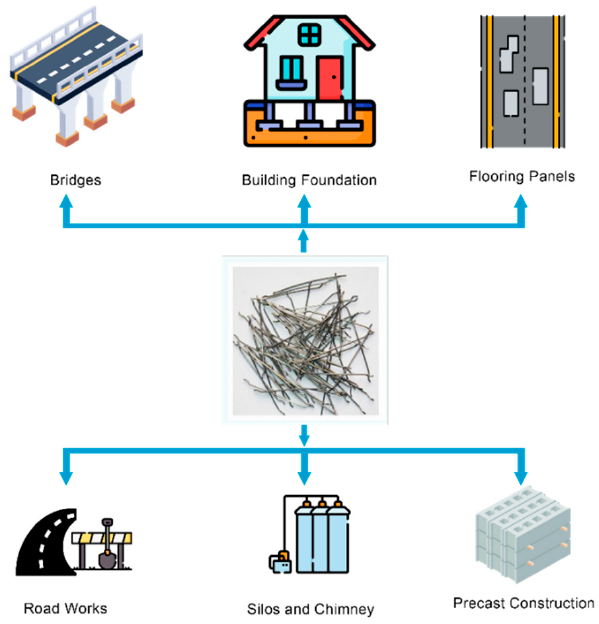
Figure 5. Utilization of steel fibers in various construction practices.